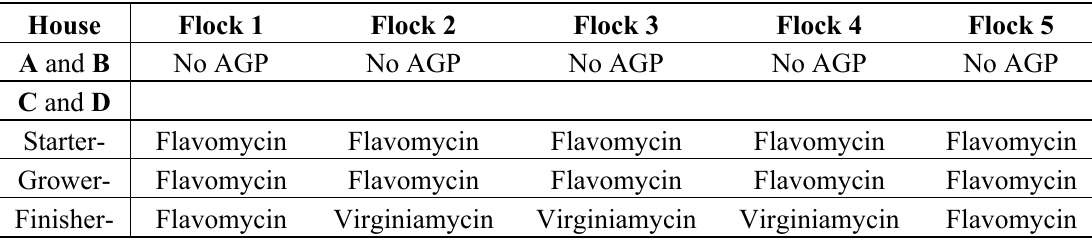
Table 1. Experimental design and treatments for broiler chickens raised on 3 commercial poultry farms. Two houses on each farm received no antibiotics; two houses received flavomycin (2.2 g/T) in the starter, and grower feed and either flavomycin (2.2 g/T) or virginiamycin (22 g/T) in the finisher